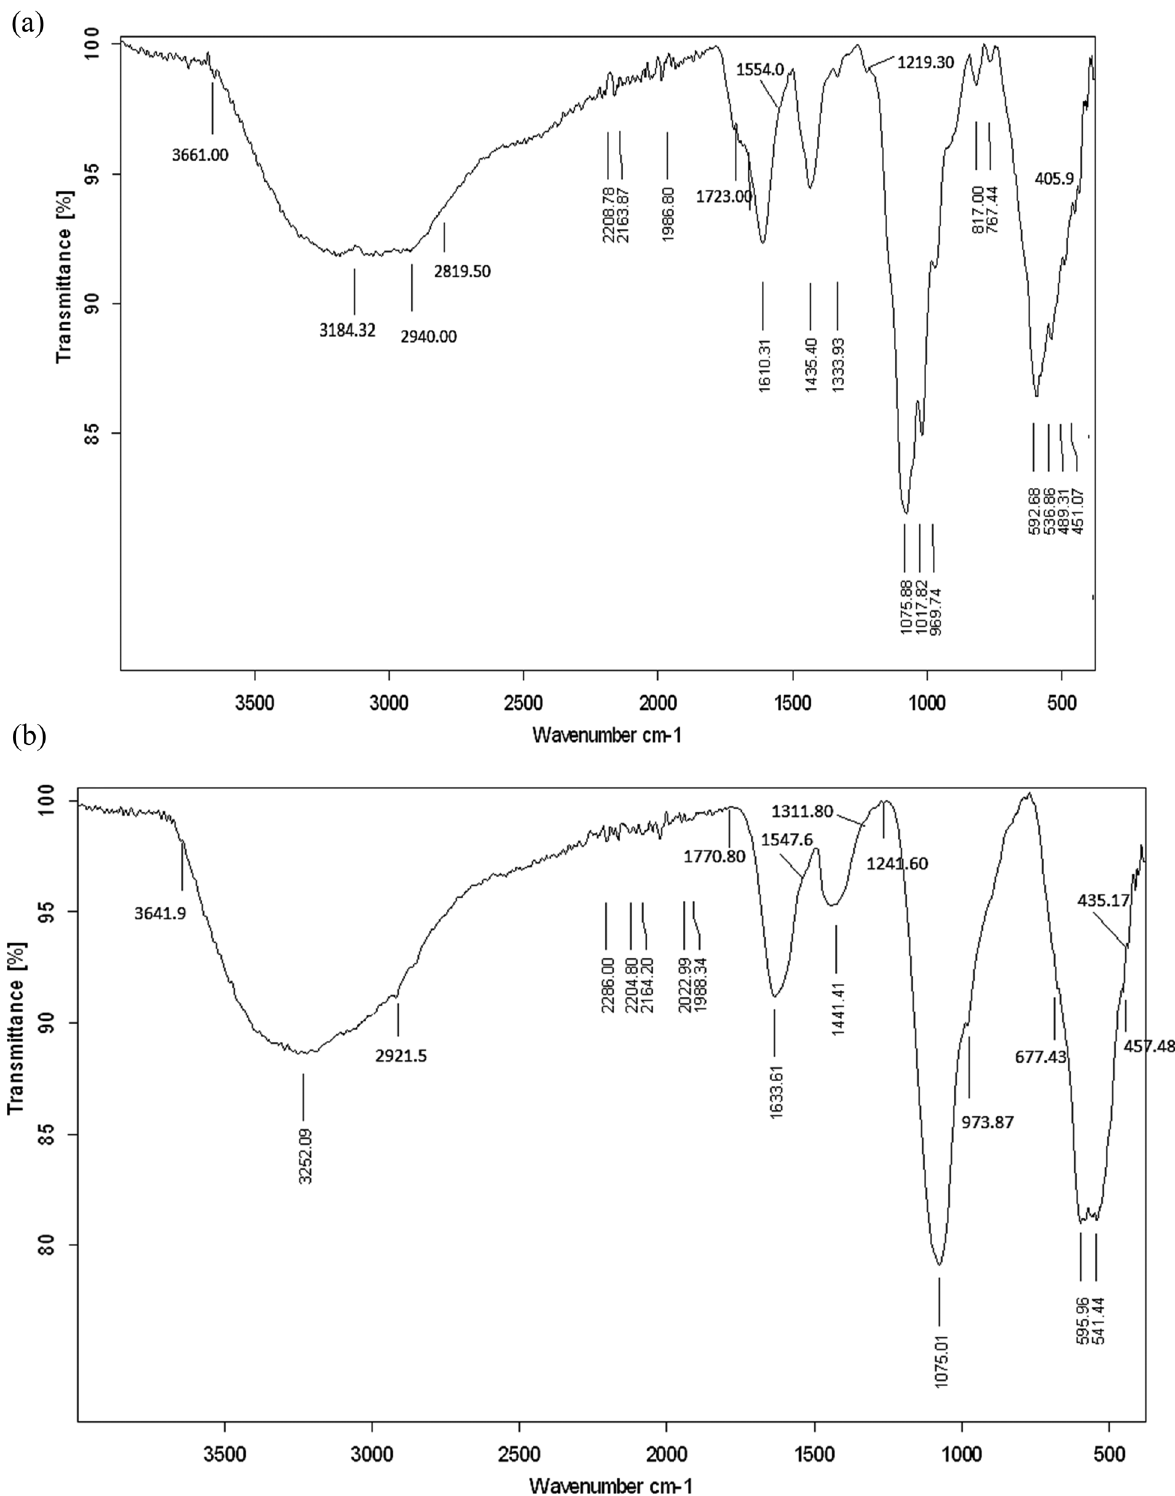
Figure 2: FT - IR spectra of pectin polysaccharide isolate from pulp ( a ) and peel ( b )